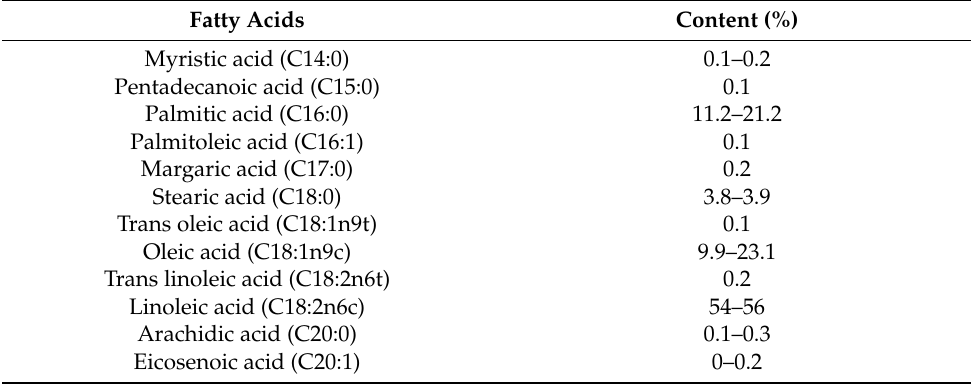
Table 2. Fatty acid profile of soybean molasses